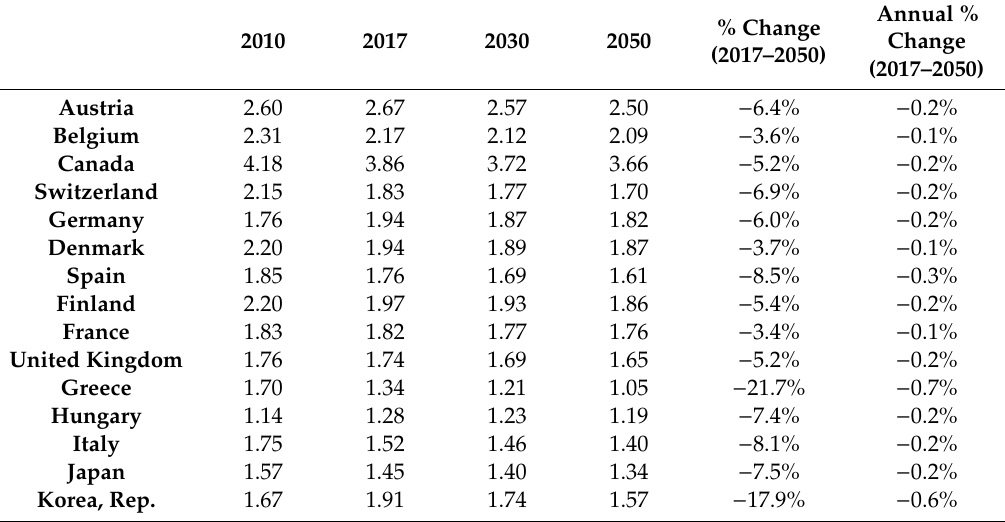
Table 5. Forecast of GHG emissions per capita in road transport (Unit: tCO 2